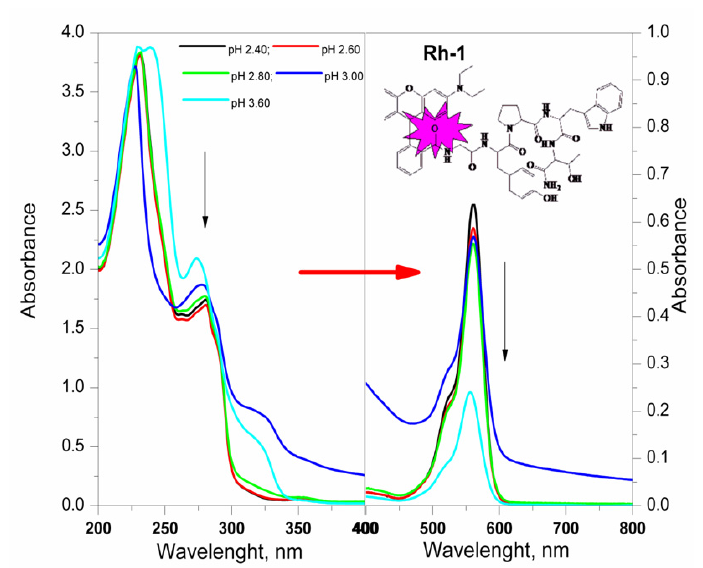
Figure 5. Uv-Vis spectrum of Rh-1 (4.09 × 10 − 5 mol L − 1 ) at different pH. A similar property of rhodamine-related peptides was observed by Meng-Chan Xia et al. [37]. Color stability was observed in the aqueous solutions of the compounds, alt- hough the intensity of the absorption maxima depended on the pH of the medium. The molar extinction coefficients in the long-wavelength absorption maximum are, respec- tively, Rh-3 ( ε = 1.83 × 10 4 cm.mol.L − 1 ); Rh-1 ( ε = 2.04 × 10 4 cm.mol.L − 1 ); and Rh-2 ( ε = 2.16 × 10 4 cm.mol.L − 1 ). The behavior of the compounds in an aprotic solution of triethylamine